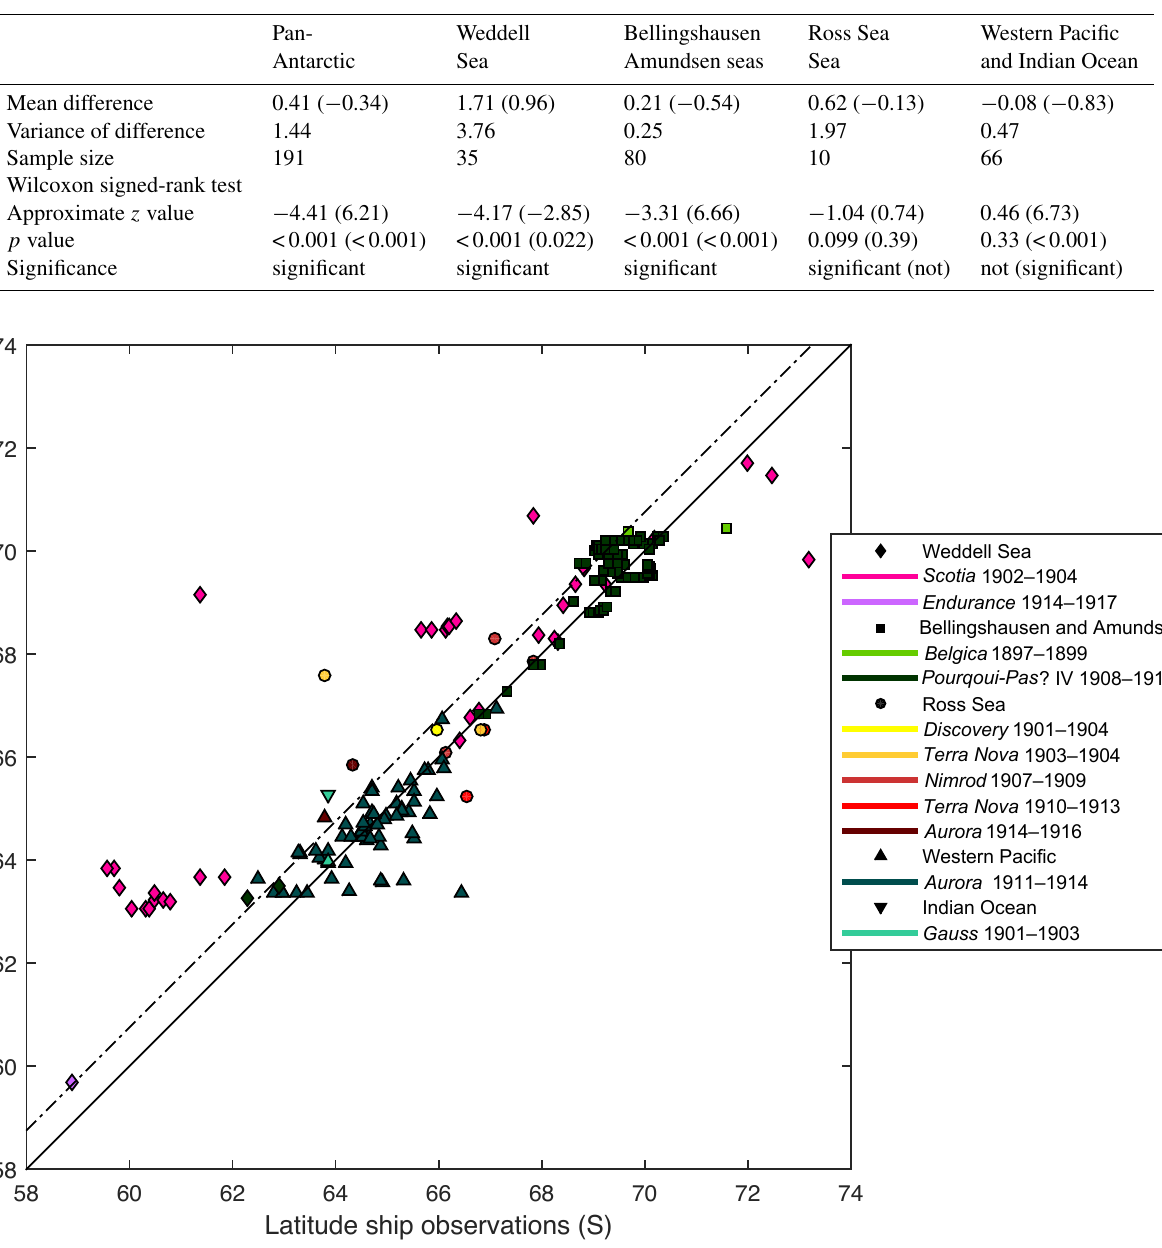
Table 2. Mean differences in ice edge latitude between the ship-observed and daily mean satellite-derived ice edge position by Antarctic sector. Positive differences indicate where the ship-observed ice edge is north of the mean satellite-derived ice edge. Bracketed quantities refer to the same difference, but with the Worby and Comiso offset subtracted.